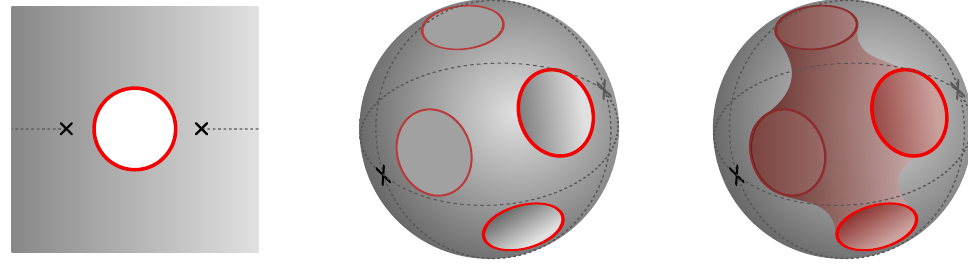
Figure 7 . Replica calculation of entanglement